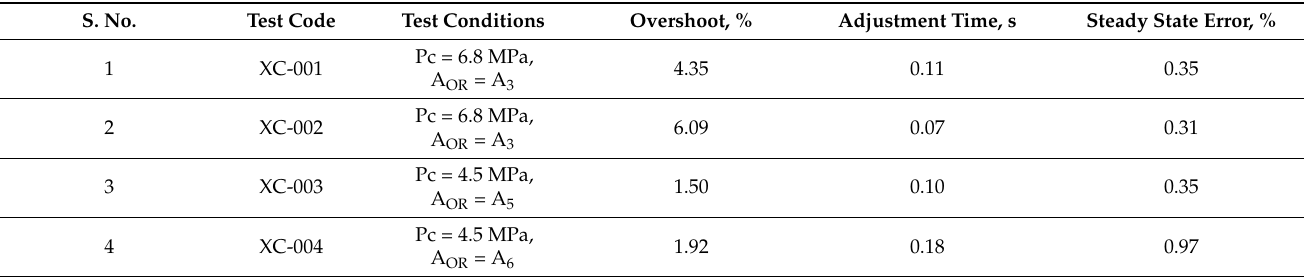
Table 2. Summary of control system